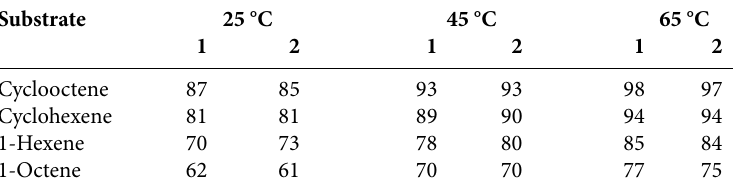
Table 3. Epoxide yields (%) for the catalytic processes at different temperatures